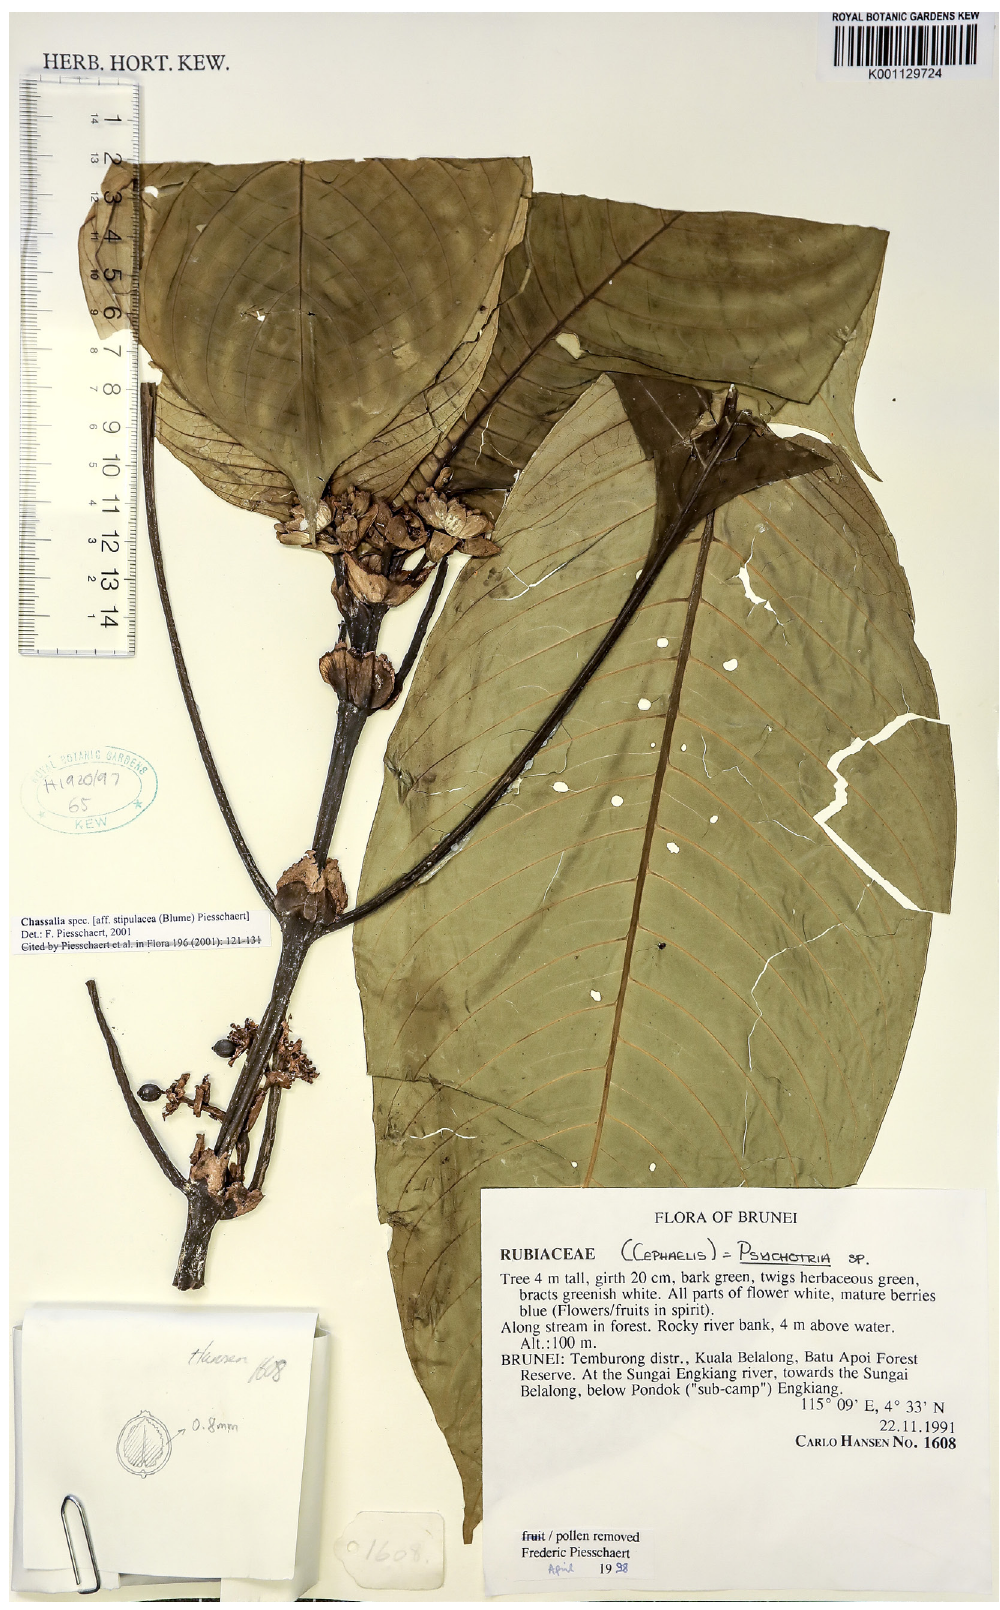
Fig. 13. Holotype of Chassalia involucrata T.Y.Yu sp. nov. ( Carlo Hansen 1608